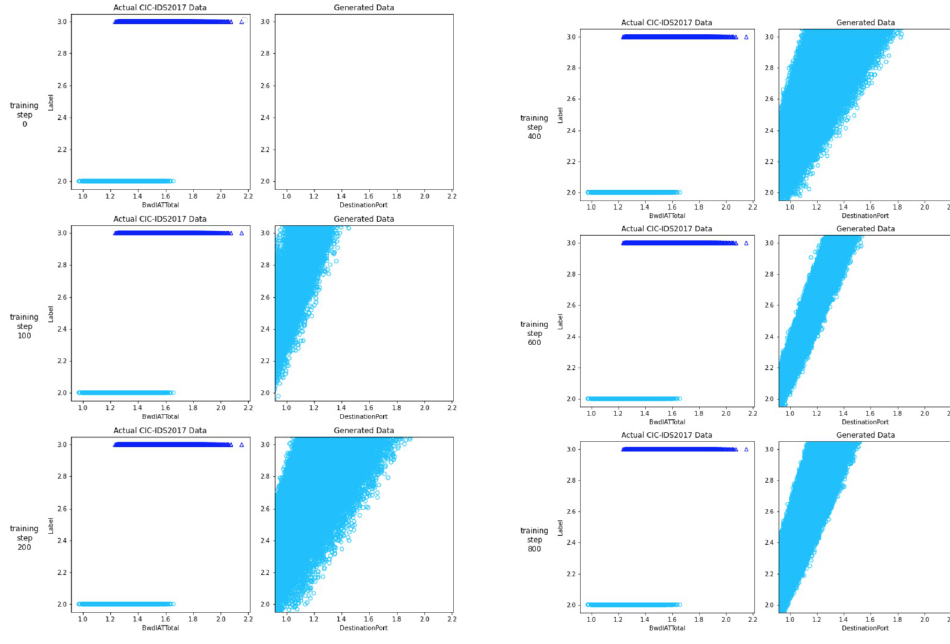
Fig 4. Comparison of GAN outputs.